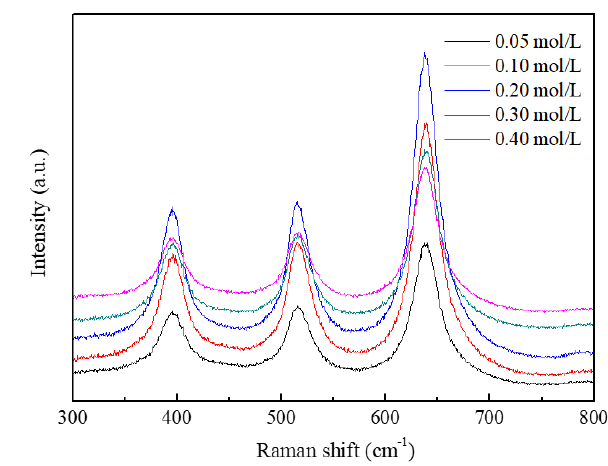
Figure 10. Raman spectra of TiO 2 films deposited with different TTIP concentrations using the mist CVD method. The adhesion between TiO 2 film and substrate was checked by ultrasonic oscillation and using adhesive tapes. All of the fabricated TiO 2 films showed good